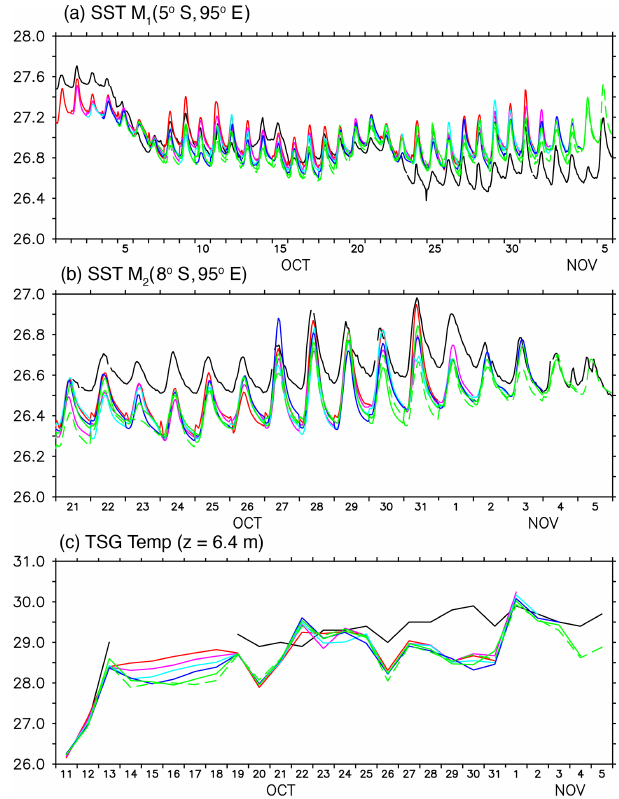
Figure 8. (a, b) Time series of hourly mean SST from model forecast and observations at the locations M 1 (5 ◦ S, 95 ◦ E) and M 2 (8 ◦ S, 95 ◦ E). Buoy locations are shown in Fig. 3. (c) Sub- surface temperature at 6.4m depth for track shown in Fig. 3 from TSG and model: observations (black line), fcst_day1 (red line), fcst_day2 (purple line), fcst_day3 (light blue line), fcst_day4 (blue line), fcst_day5 (green line), and fcst_day6 (dashed green